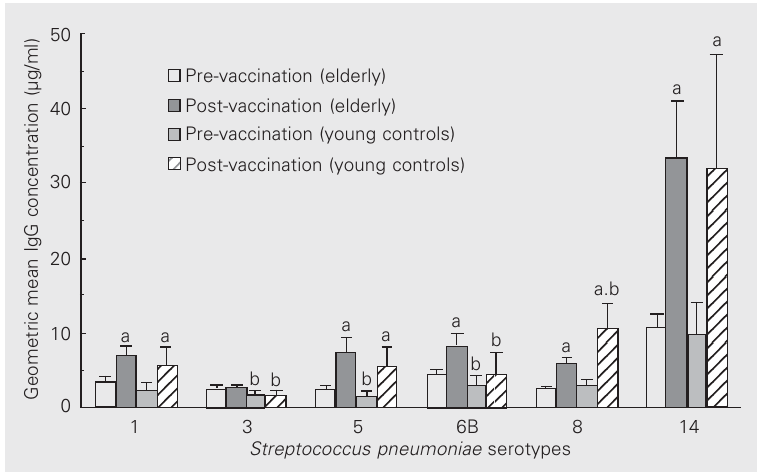
Figure 1. Geometric mean concentration and 95% confidence intervals of IgG specific for pneumococcal capsular polysaccharide in serum samples from 102 elderly and 19 young adults, pre- and post-vaccination. a P < 0.05 for pre-vaccination sera compared to post- vaccination sera; b P < 0.05 for young adults compared to elderly subjects (analyses of variance for repeated